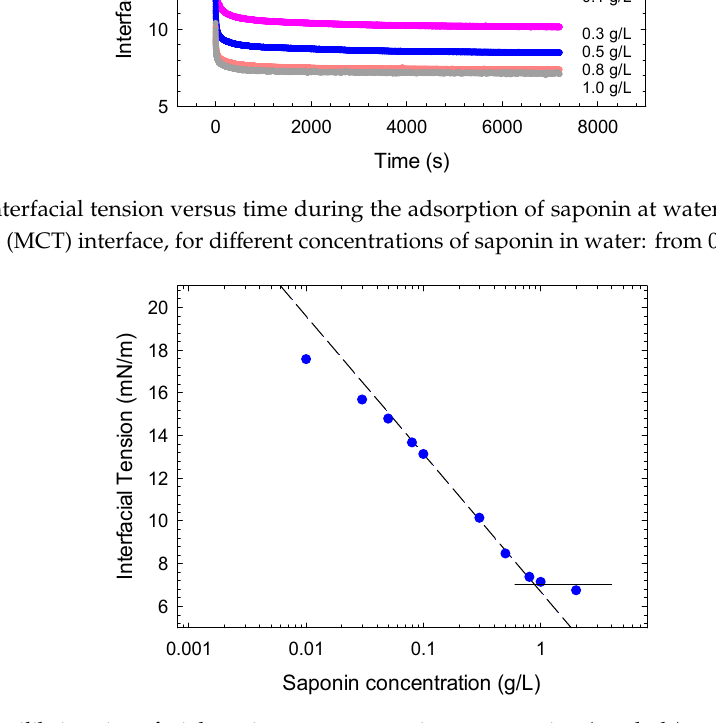
Figure 3. Equilibrium interfacial tension versus saponin concentration (symbols) and linear fitting of the experimental data close to the cmc providing through Equation (1) the maximum adsorption Γ max = 2.6 μ M/m 2 .